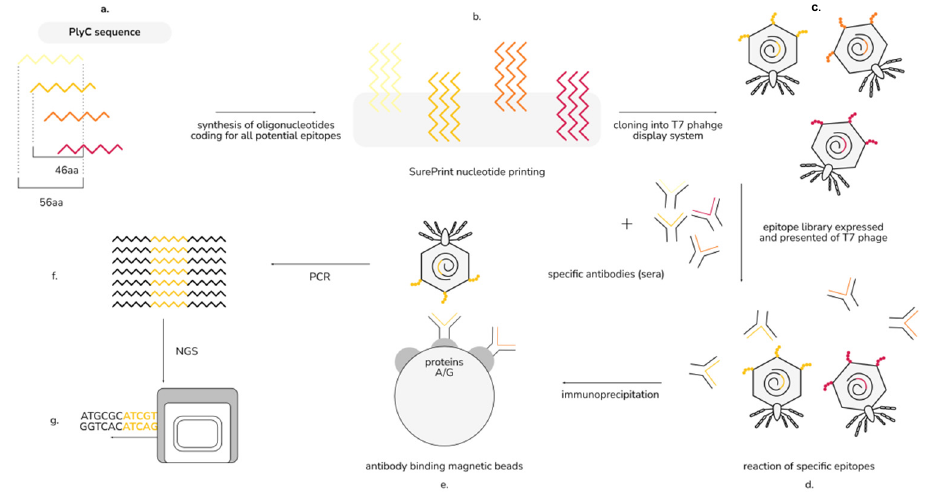
Figure 2. EndoScan technology for the identification of immunogenic regions in PlyC: ( a ) in silico design of peptides covering the sequences of PlyC; ( b ) synthesis of oligonucleotides coding for the peptides; ( c ) construction of a phage display library of PlyC-derived peptides; ( d ) a reaction of the library with specific sera; ( e ) immunoprecipitation with magnetic beads binding Fc fragments of antibodies; ( f ) amplification by PCR reaction; ( g ) next-generation sequencing (NGS) (modified from Xu et al. [14]).